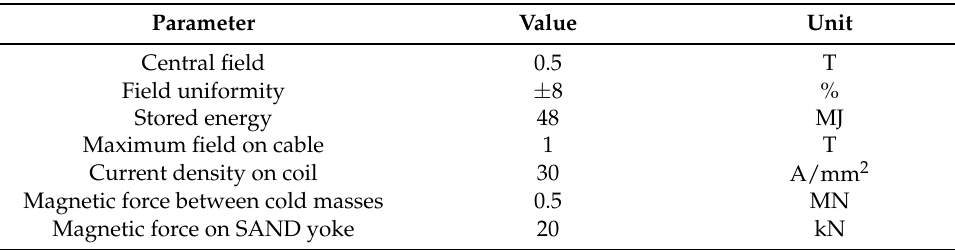
Table 13. Main features of the SPY ND-GAr reference magnet design.